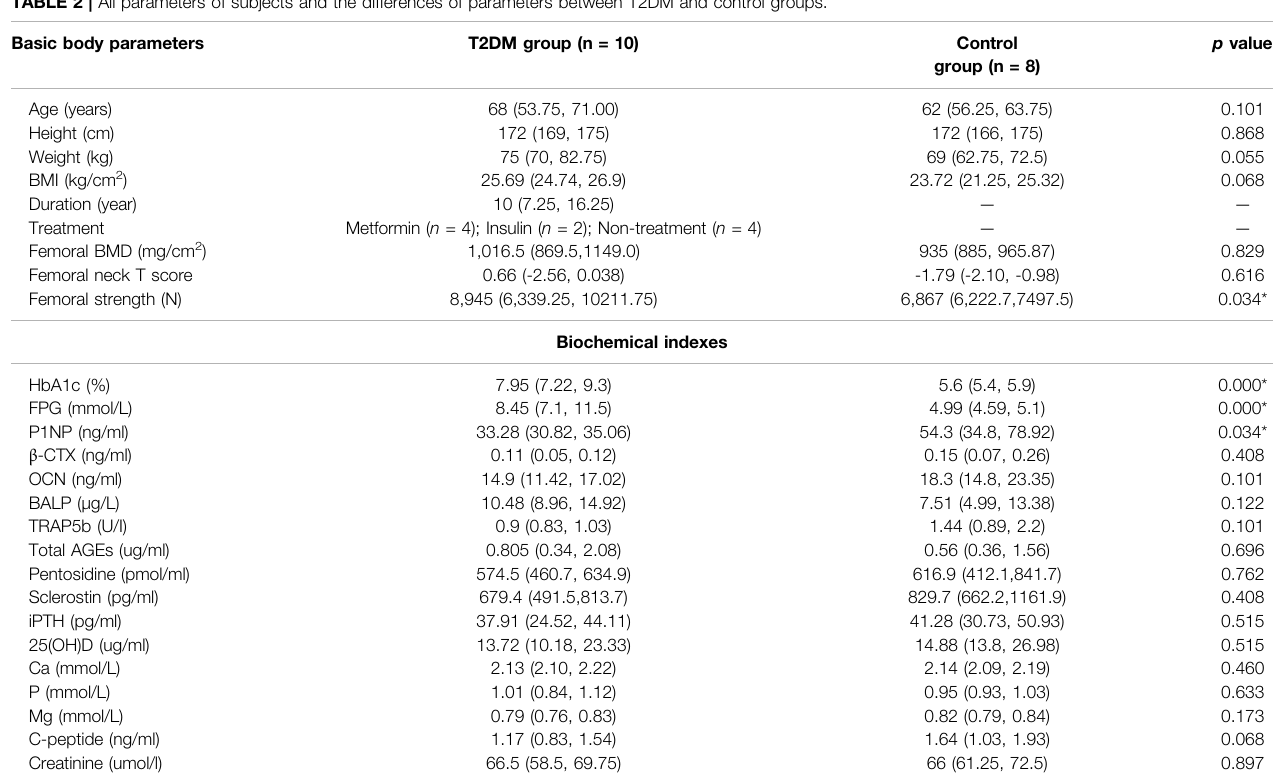
TABLE 2 | All parameters of subjects and the differences of parameters between T2DM and control groups. Basic body